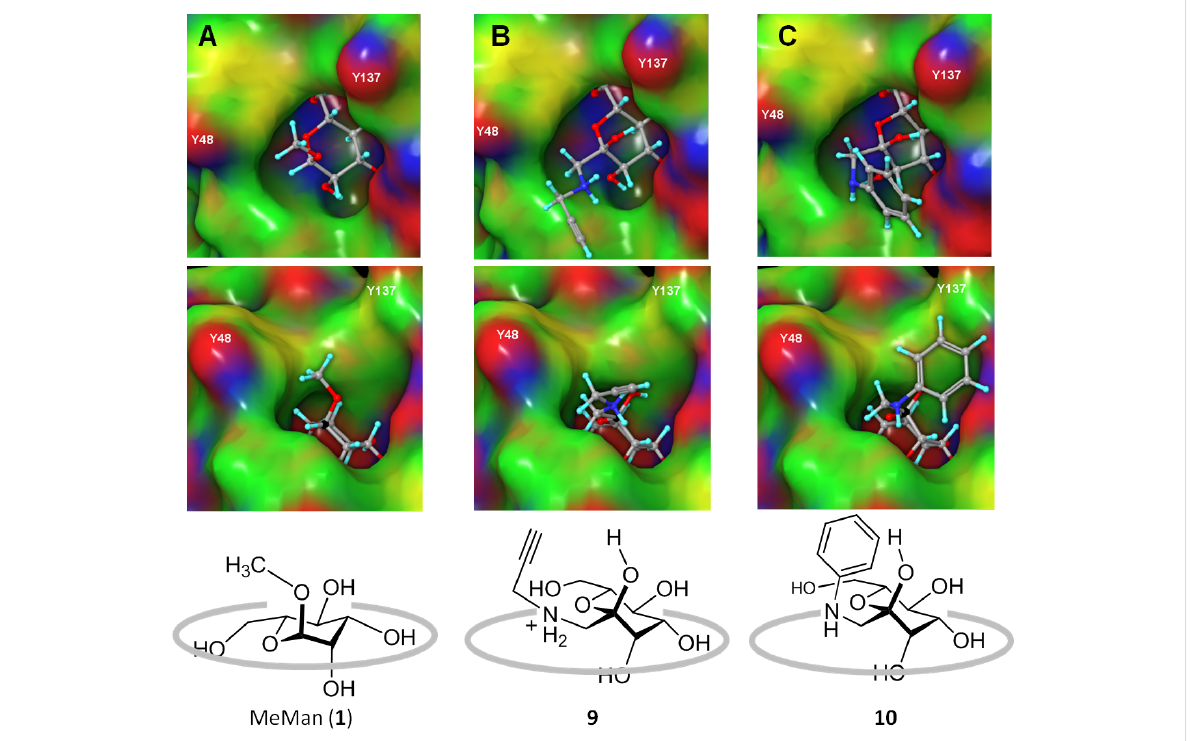
Figure 3: Partial charge coloured Connolly descriptions [28,29] (negative partial charges coloured in red, positive in blue) of mannoside MeMan ( 1 ) (A) and the Amadori products 9 (B) and 10 (C) as complexed within the CRD of FimH (PDB 1KLF, open gate structure). Top row: view from above the CRD; middle row: side view, with respective anomeric carbon atoms highlighted in black; bottom row cartoons (not to scale) correspond to side views and are drawn to illustrate that Amadori products 9 and 10 are lifted from the carbohydrate binding site resulting in diminished affinity.